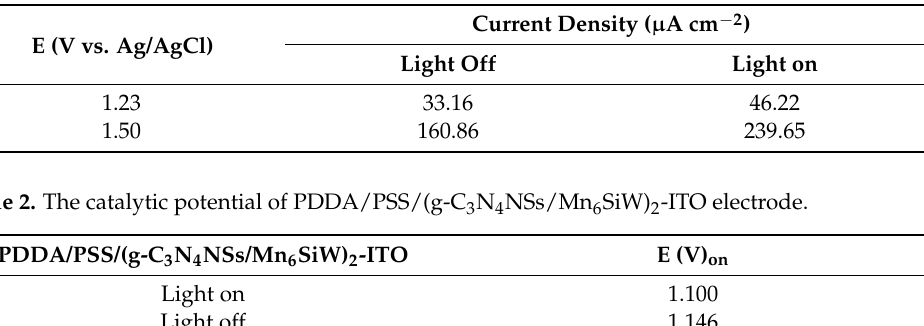
Table 1. The current density of PDDA/PSS/(g-C 3 N 4 NSs/Mn 6 SiW) 2 -ITO electrode.